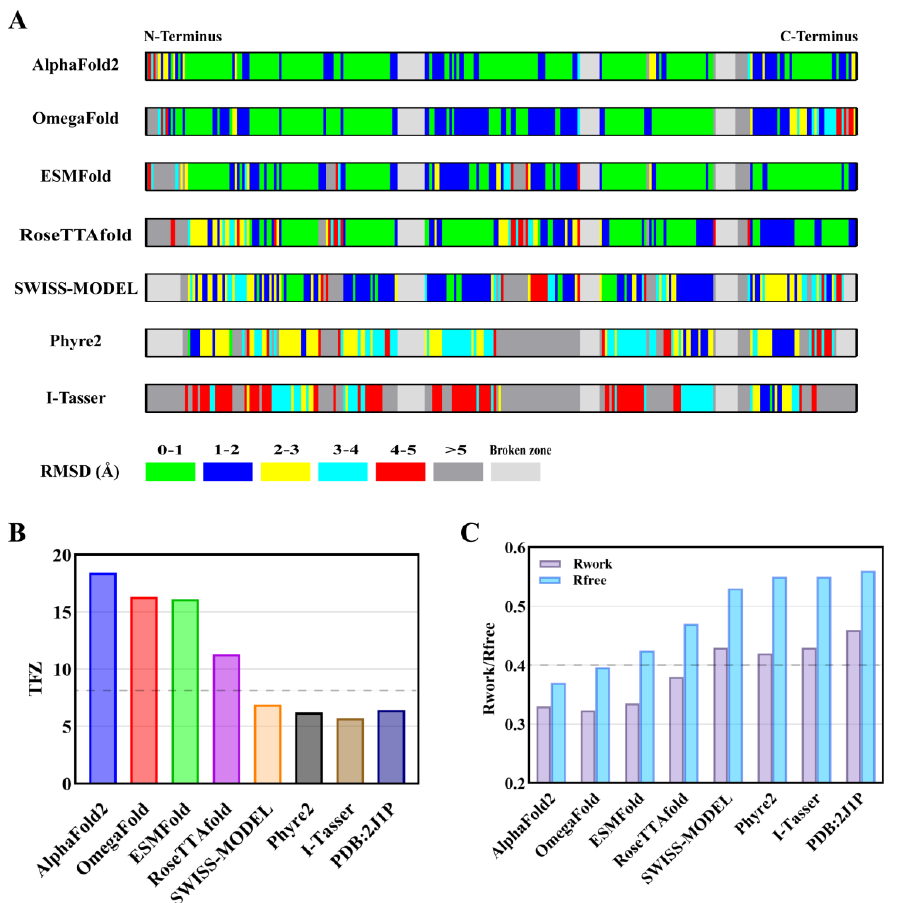
Figure 4. Comparison of different computational models with respect to B318L crystal structure and their applications in crystal structural determination. ( A ) Stripe diagram depicting the calculated per-residue RMSD distribution of each predicted model against the B318L crystal structure after pairwise structural alignment. The series of amino acid residues serve as the x-axis and the N/C termini are annotated at both ends of the stripe. The color codes for different regions of RMSD values are indicated at the bottom left corner. Note that the light gray bar represents broken backbones in the crystal structure that cannot be built due to the lack of observed electron densities or that cannot be predicted in the models. ( B ) A comparison of the best TFZ scores obtained from molecular replacement trials with each model as a search template. The dashed line indicates a TFZ value of 8.0, above which is usually deemed as a correct solution. ( C ) A comparison of paired Rwork and Rfree factors generated by Phenix.refinement from each MR solution against experimental data. The dashed line suggests an R factor of 0.4, below which is generally considered a potentially solvable structure.